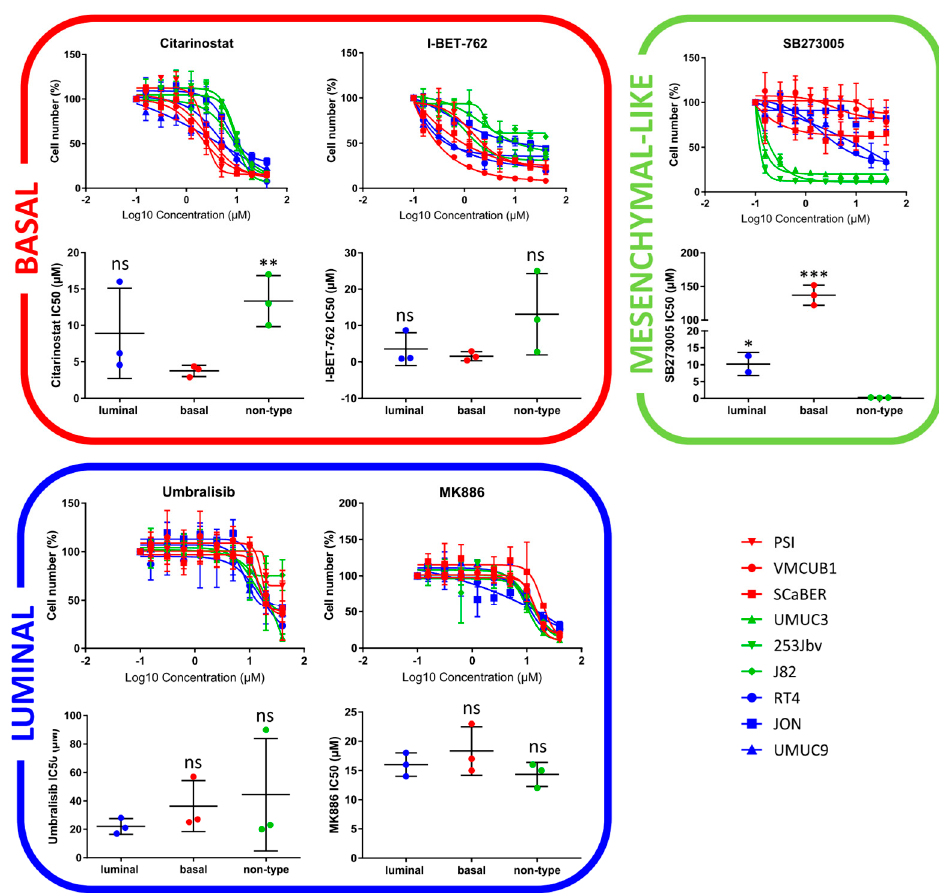
Figure 3. Validation of lead hits via drug response curves in subtype-specific cell lines. Basal: PSI, VMCUB1, SCaBER/Luminal: RT4, JON, UMUC9/Mesenchymal-like: UMUC3, 253Jbv, J82 ( p < 0.033: *, p < 0.002: **, p < 0.001: ***).